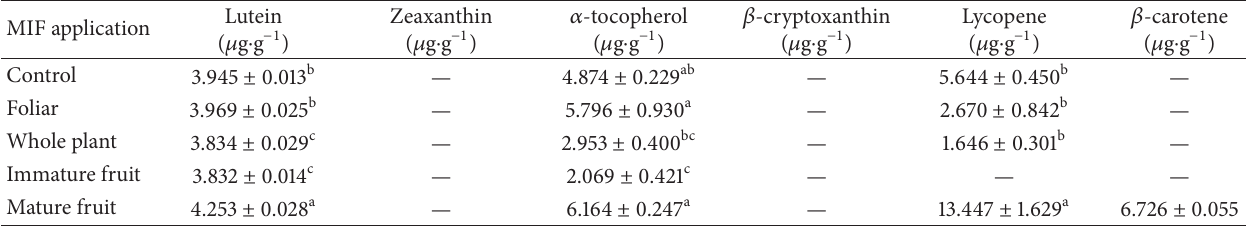
Table 2: Carotenoid profile of sweet bell pepper as a result of MIF application ∗ . MIF application